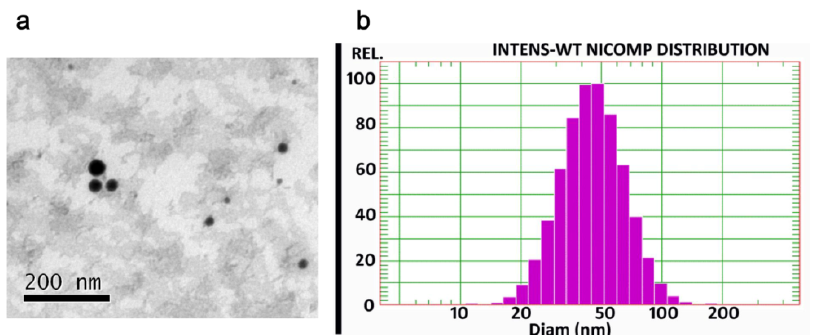
Figure 2. Transmission electron microscopy ( a ) and size distribution ( b ) of the aconitine-loaded microemulsion.